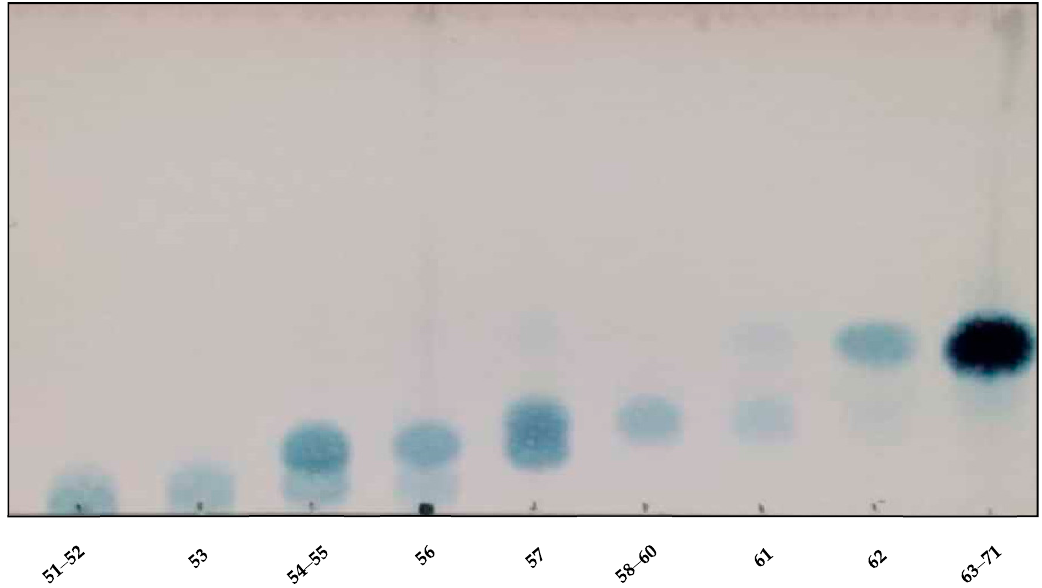
Figure 2. TLC of the counter-current chromatography (CCC) fractions of the Sephadex 8–15 of Adenocalymma marginatum (silica gel, EtOAc: formic acid: H2O: acetone 10:2:3:1).